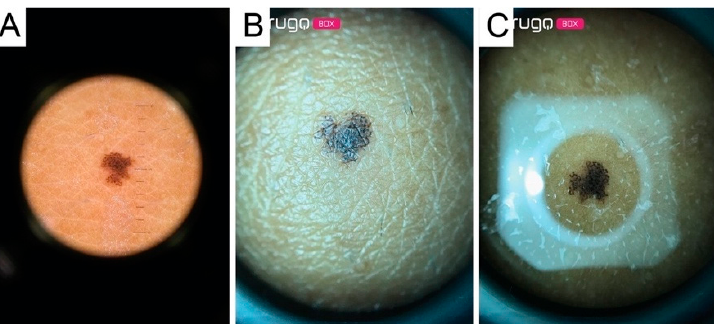
Figure 4. Image of a malignant melanoma acquired through: ( A ) contact dermatoscope; ( B ) Nurugo TM microscope without laboratory glass; ( C ) Nurugo TM microscope with laboratory glass. The arrows in Figure 4A and Figure 4B clearly point out where the shadow effect and glare effect can be easily seen.